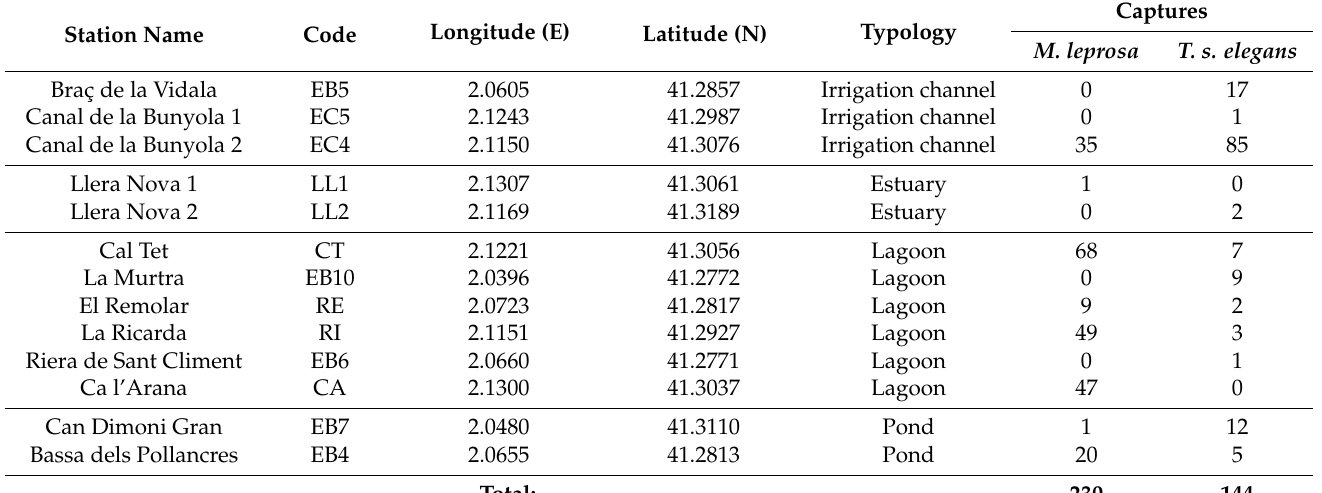
Table 3. Sampling stations and number of captures per species.